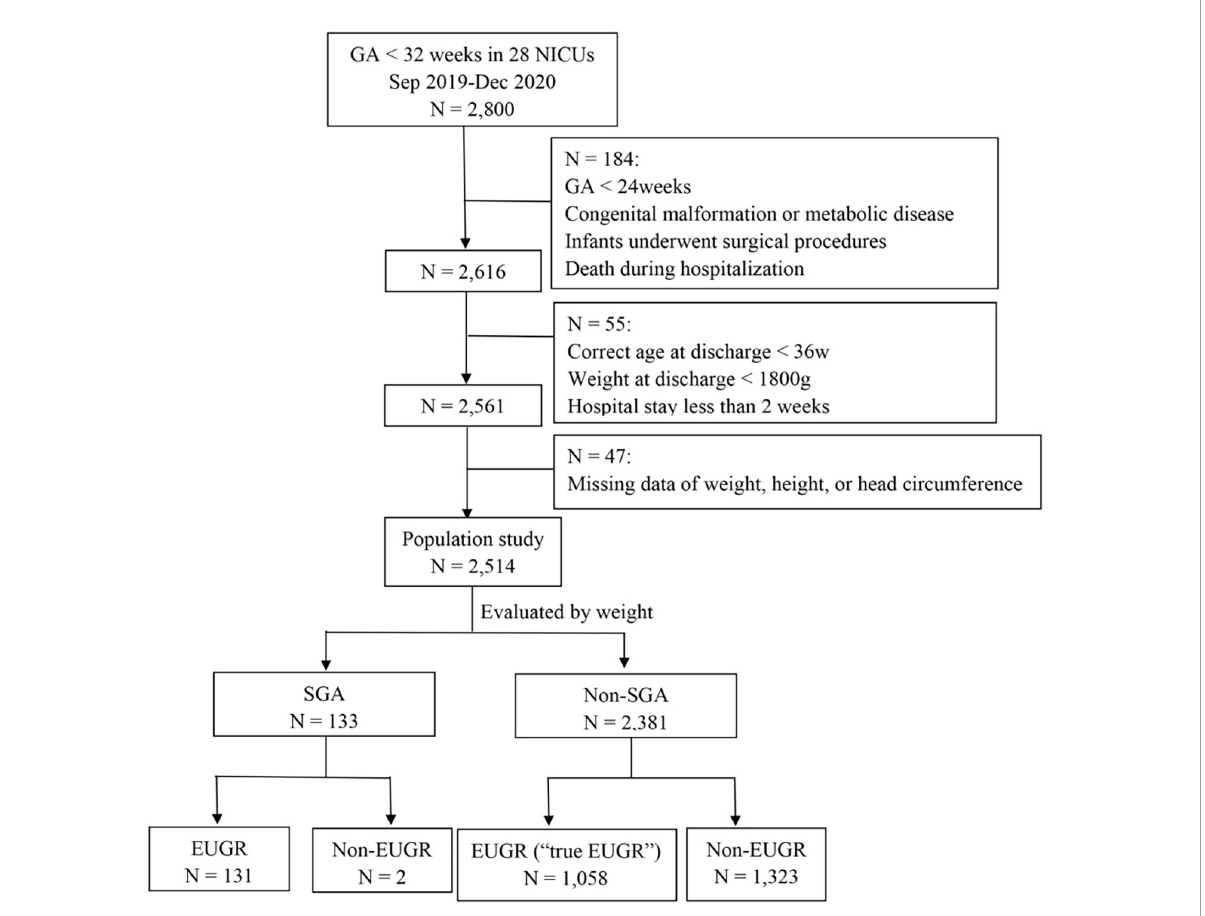
FIGURE1 The flow chart of the included infants. GA, gestational age; NICU, neonatal intensive care unit; SGA, small for gestational age; EUGR, extrauterine growth